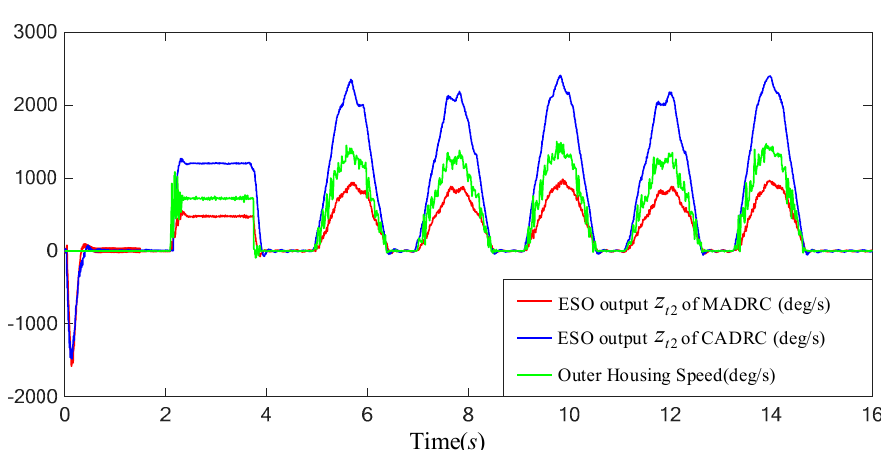
Figure 24. The ESO outputs of MADRC, CADRC, and the outer housing speed.